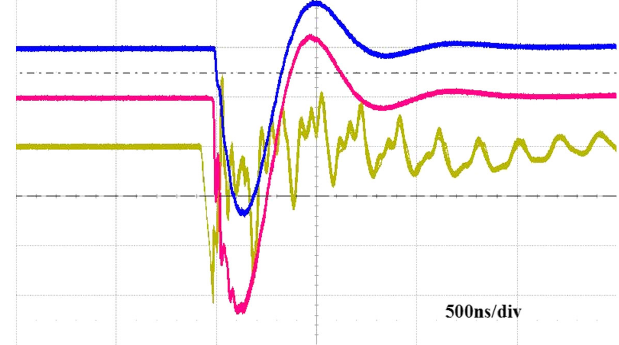
FIG. 12. 50 consecutive discharge waveforms of the four-stage